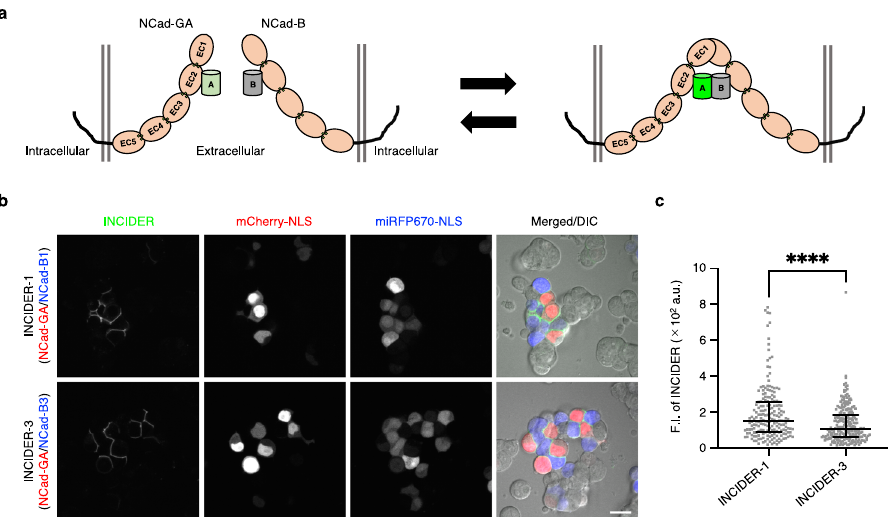
Fig. 1 Design of an intensiometric NCad interaction indicator using ddGFP. a Schematics of intercellular NCad interactions by INCIDERs. NCad is represented by fi ve serially repeated extracellular domains (EC domains). In NCad-GA and NCad-B constructs, ddGFP-A and ddFP-B are inserted in the EC2 domain of NCad. By binding of NCad-GA with NCad-B, ddGFP-A and ddFP-B form a heterodimer, resulting in green fl uorescence. b Fluorescence and DIC images of intercellular NCad interaction. HEK293T cells individually expressing INCIDER components, i.e. NCad-GA and NCad-B (NCad-B1 or NCad- B3) were co-cultured, and then observed using a confocal microscope. mCherry-NLS and miRFP670-NLS were bicistronically co-expressed with NCad-GA and NCad-B, respectively to distinguish cells. Scale bar, 20 μ m. c INCIDER fl uorescence signals at the cell adhesion sites were quanti fi ed and compared between INCIDER-1 and INCIDER-3. Results are presented as lower quartile (lower whisker), median (center line), and upper quartile (upper whisker). A signi fi cant difference was analyzed by Mann – Whitney U test. **** p < 0.0001. 189 (INCIDER-1) and 244 (INCIDER-3) cell adhesion sites were analyzed from two independent